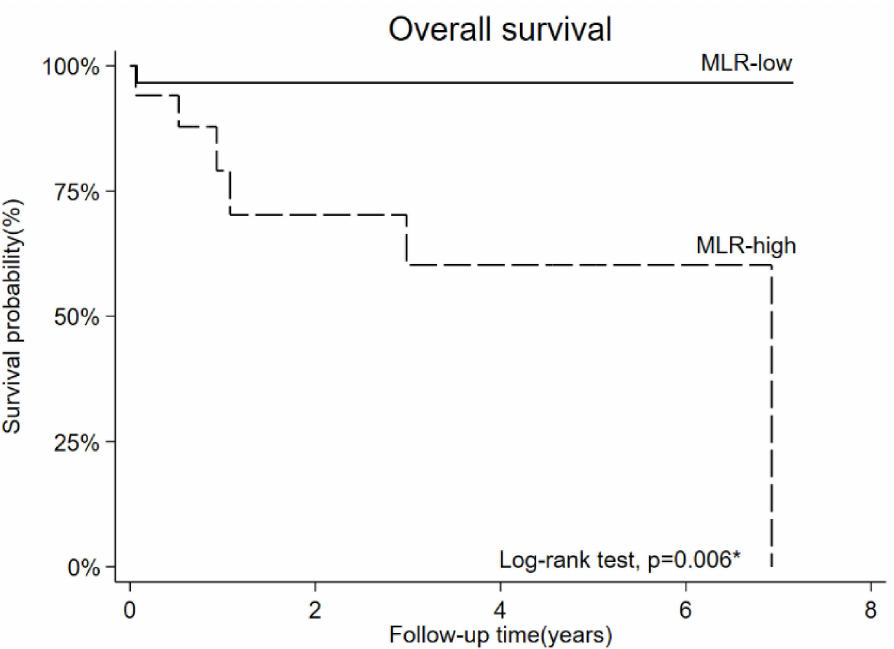
Figure 5. Overall survival stratified by high and low monocyte/lymphocyte ratio (MLR) (5-year survival rate = 96% and 60% in the MLR-low and MLR-high groups,